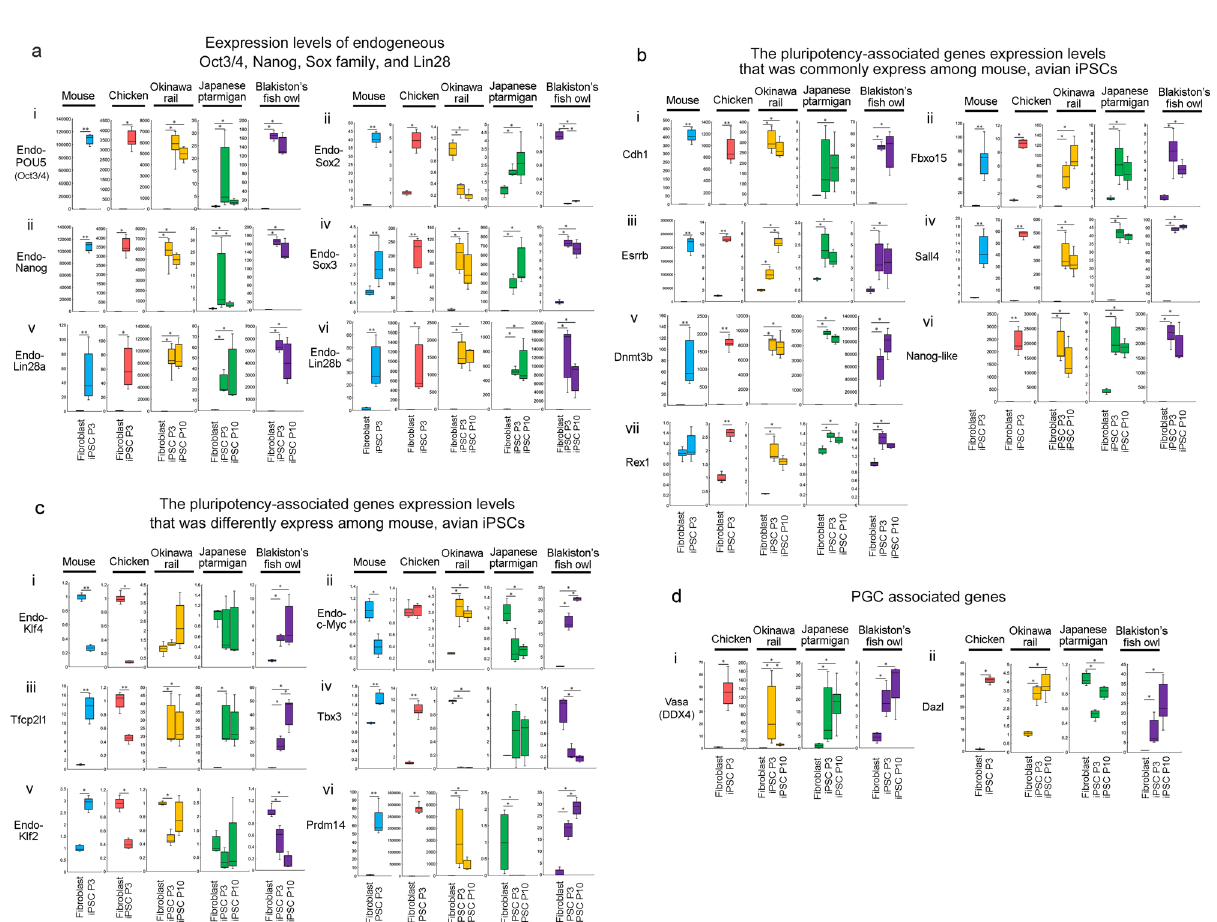
Fig. 3 Analysis of pluripotency-related gene expression in mouse, chick, Okinawa rail, Japanese ptarmigan, and Blakiston ’ s fi sh owl-derived iPSCs and parent fi broblasts. a mRNA expression levels of POU5 (mammalian Oct3/4 ), Nanog, Sox family, and Lin28 in mouse, chicken, Okinawa rail, Japanese ptarmigan, and Blakiston ’ s fi sh owl-derived iPSCs and fi broblasts. endo- POU5 (mammalian Oct3/4 ) (i), endo- Sox2 (ii), endo- Nanog (iii), Sox3 (iv), endo- Lin28a (v), and endo- Lin28b (vi) represents. b Pluripotency-associated genes commonly expressed in mouse, chick Okinawa rail, Japanese ptarmigan, and Blakiston fi sh owl iPSCs. Cdh1 (i), Fbxo15 (ii), Esrrb (iii), Sall4 (iv), Dnmt3b (v), Nanog-like (vi), and Rex1 (vii) represents. c Pluripotency-associated genes differentially expressed in mouse, chick Okinawa rail, Japanese ptarmigan, and Blakiston fi sh owl iPSCs. Endo- Klf4 (i), Endo- c-Myc (ii), Tfcp2l1 (iii), Tbx3 (iv), Endo- Klf2 (v), and Prdm14 (vi) represents. d mRNA expression levels of primordial germ cell (PGC) marker genes. Vasa (i), Dazl (ii) represents. Gene expression was quanti fi ed relative to the GAPDH internal control. The fi broblast expression level was 1.0. Blue bars, mouse; red bars, chicken; yellow bars, Okinawa rail; green bars, ptarmigan; and purple bars, Blakiston ’ s fi sh owl-derived cells. Mouse and chicken: Fibroblasts and the iPSCs (passage number 3; P3) represents. Okinawa rail, Japanese ptarmigan, and Blakiston ’ s fi sh owl: Fibroblasts, iPSCs (P3), and iPSCs (P10) represents. Centerlines of box plots indicate medians; box limits indicate the 25th and 75th percentiles. n = 4 (Chicken fi broblast in Pou5 , Sox2 , Nanog , Lin28a , Lin28b , Cdh1 , Fbxo15 , Esrrb , Klf4 , Tbx3 , Klf2 , Prdm14 , Vasa , and Dazl . Okinawa rail fi broblast in Sox2 , Esrrb , Klf4 , Tbx3 , and Klf2 .), n = 6 (other). * P < 0.05, ** P <